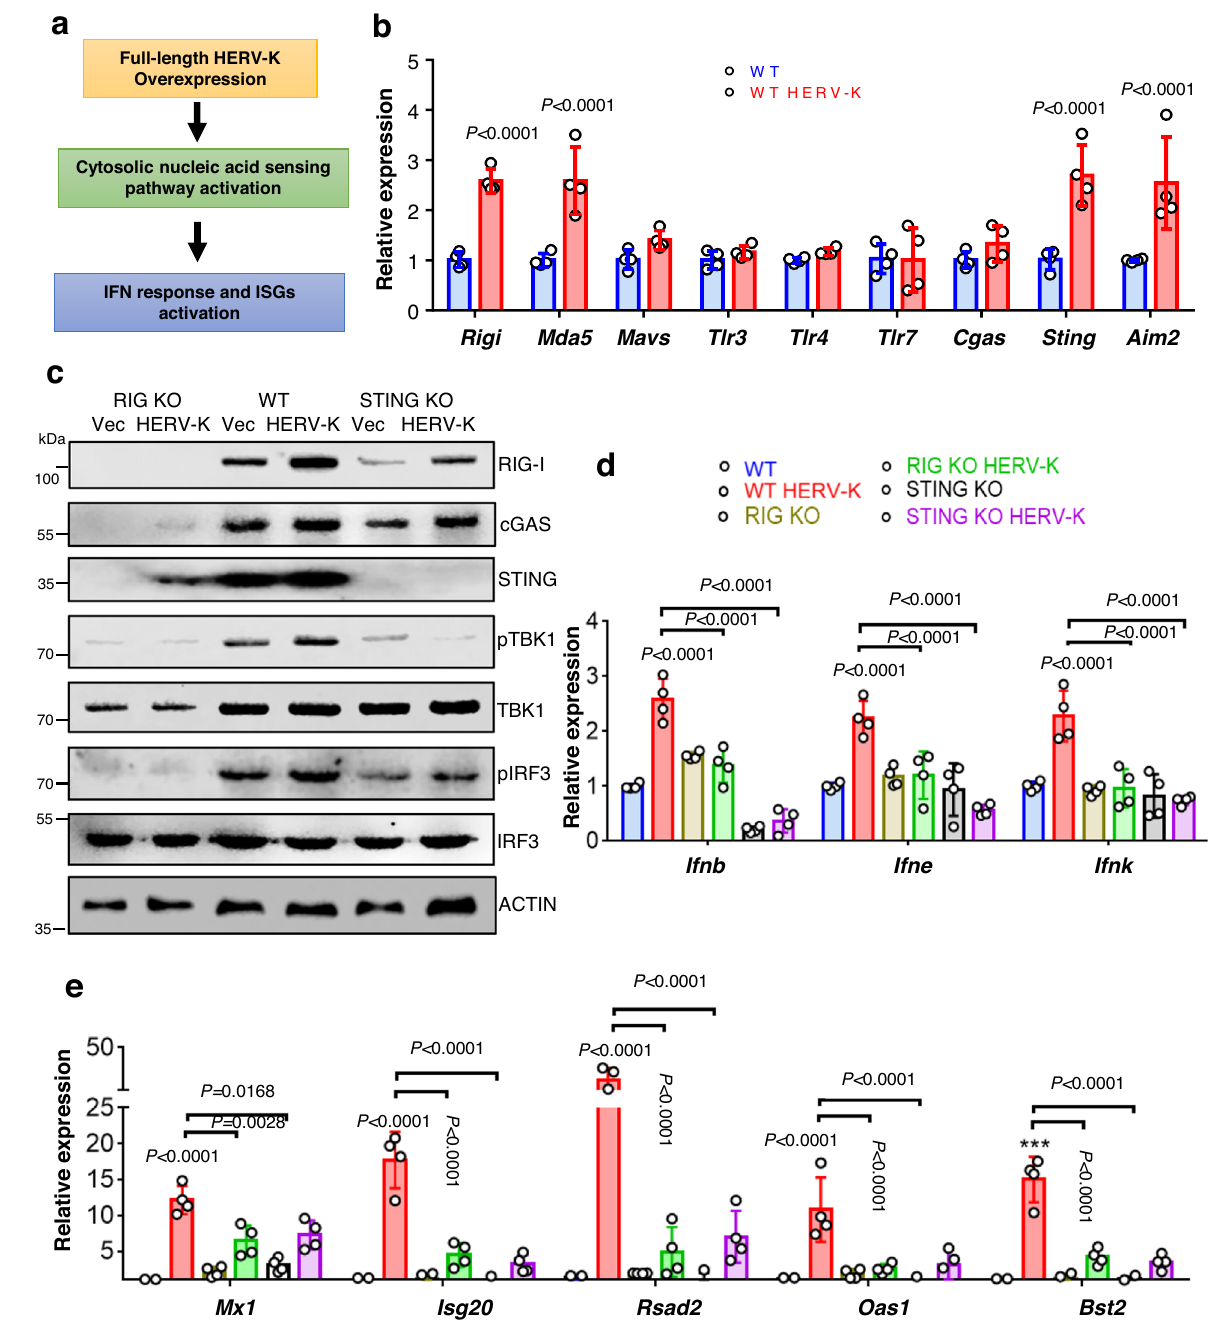
Fig. 3 | HERV-K expression activates nucleotide sensing pathways in proximal tubule cells. a Experimental hypothesis. b Relative mRNA levels of cytosolic RNA sensors ( Rigi, Mda5, Mavs, Tlr3, Tlr4 , and Tlr7 ) and DNA sensors Cgas, Sting , and Aim2 in WT PTECs transfected with HERV-K (red) or Vector control (blue) ( n =3 in each). c WesternblotshowingrepresentativeimagesofRIG-I,cGAS,STING,pTBK1, TBK1, pIRF3, and IRF3 protein levels in WT, RIG KO, and STING KO PTECs trans- fected with HERV-K/Vector. ACTIN was used as a loading control. d Ifnb, Ifne , and Ifnk RNA expression in WT (Vector: blue, HERV-K: red), RIG KO (Vector: yellow,